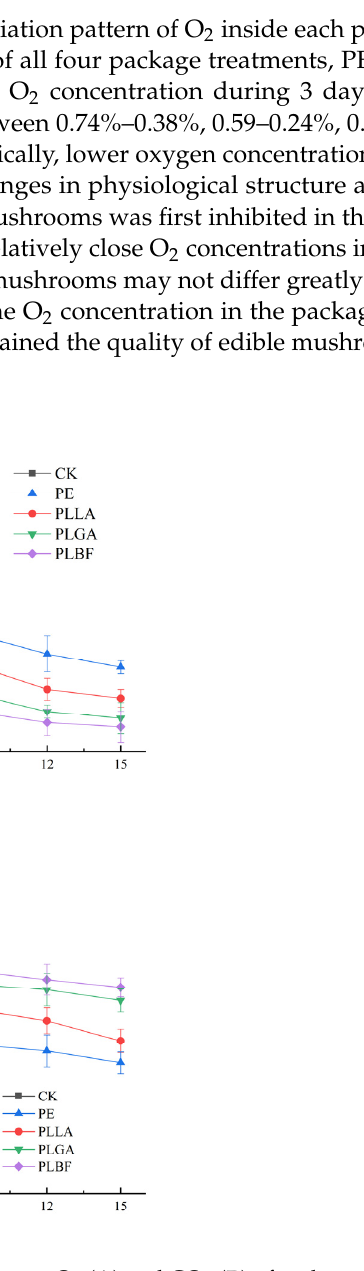
Figure 3. Changes in gas components O 2 ( A ) and CO 2 ( B ) of each packaging group during storage.